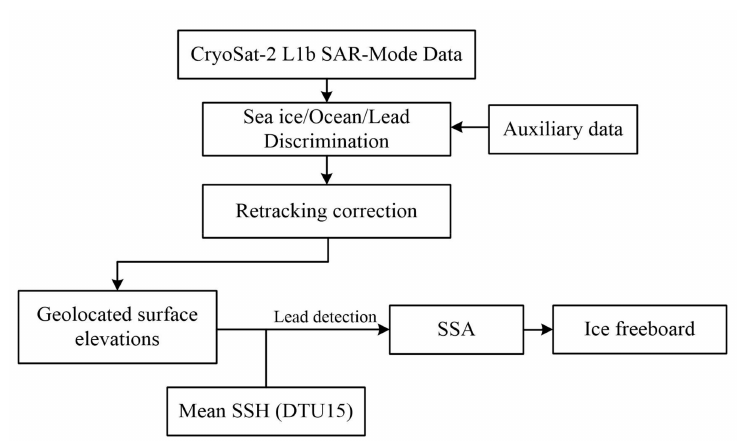
Figure 3. Flowchart of the CS-2 ice freeboard retrieving algorithm. Here, SSH is sea surface height and SSA is sea surface height anomaly,